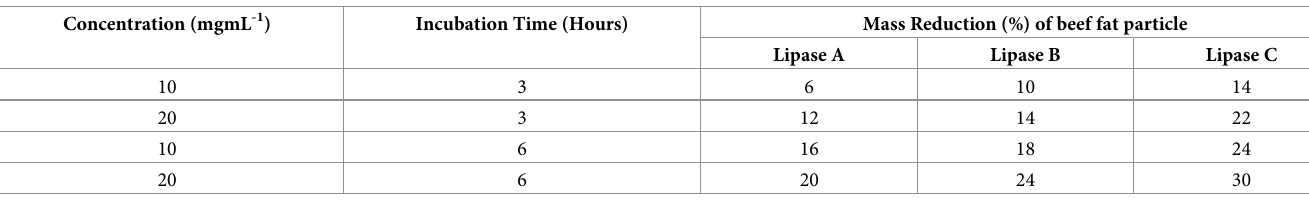
Table 8. Percent mass reduction of beef fat particle for Lipase A, B, and C. Concentration (mgmL -1